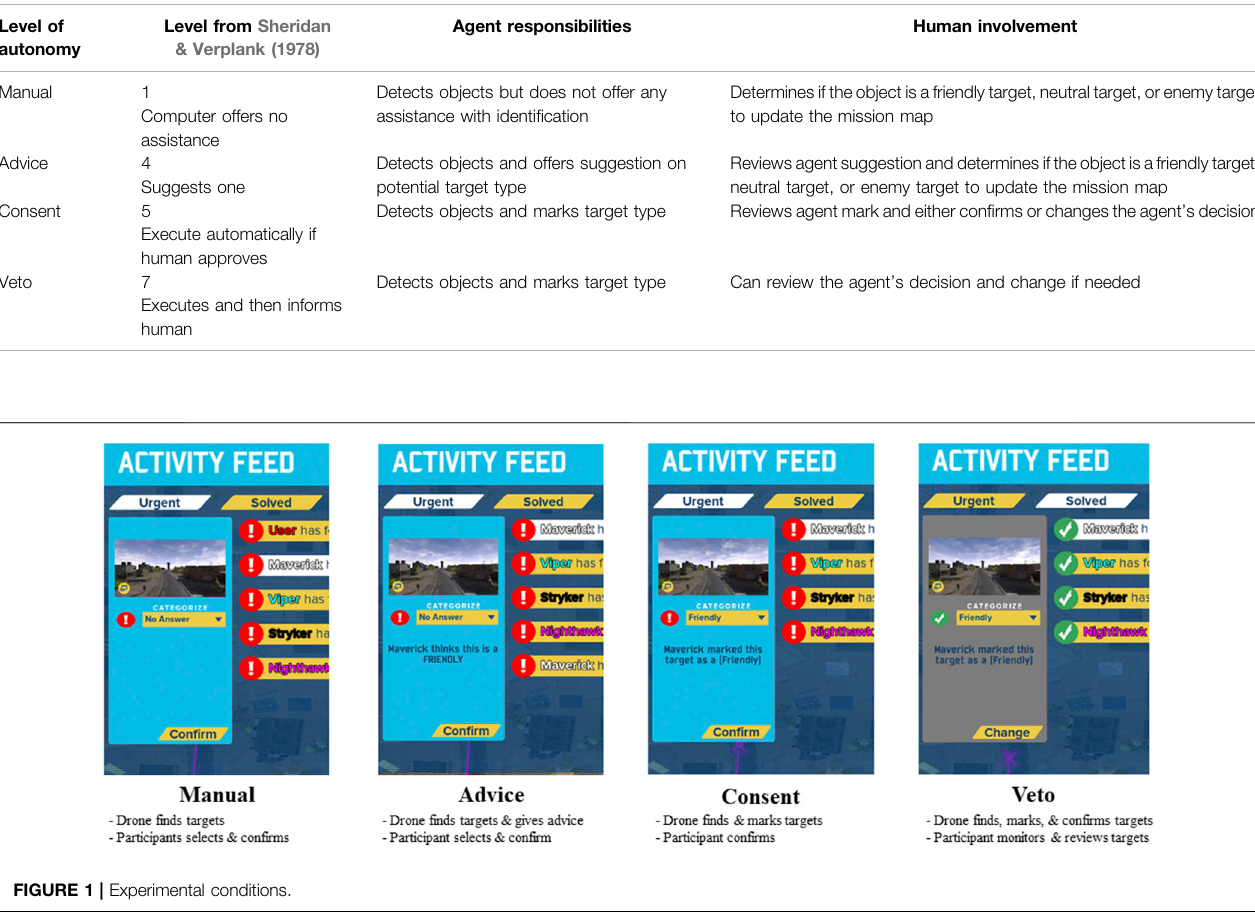
Table 2 and illustrated in Figure 1 . The participants received all